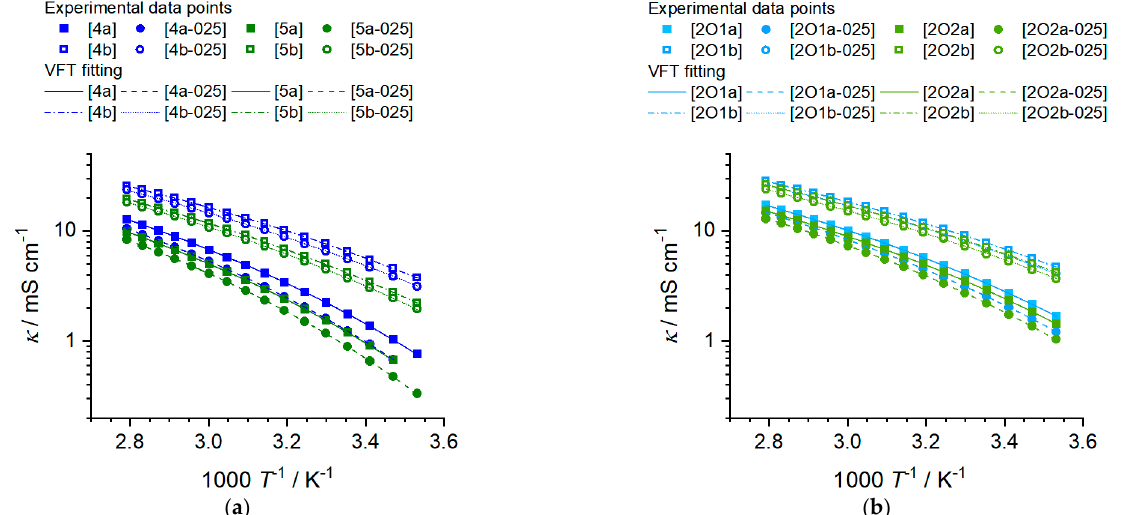
Figure 6. Conductivity data of the ILs and IL–salt mixtures. ( a ) n ‐ alkyl phosphonium ionic